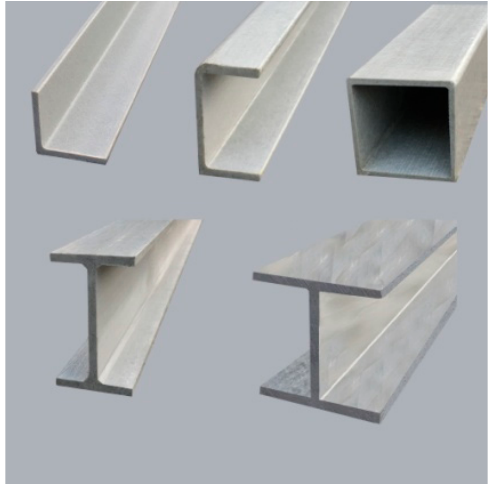
Figure 10. Examples of composite pultruded profiles [54]. The problem of low stiffness of FRP beams can be solved by using hybrid girders, which are a combination of composite beams with other materials, most often concrete. An example of such a solution is shown in the Figure 11.